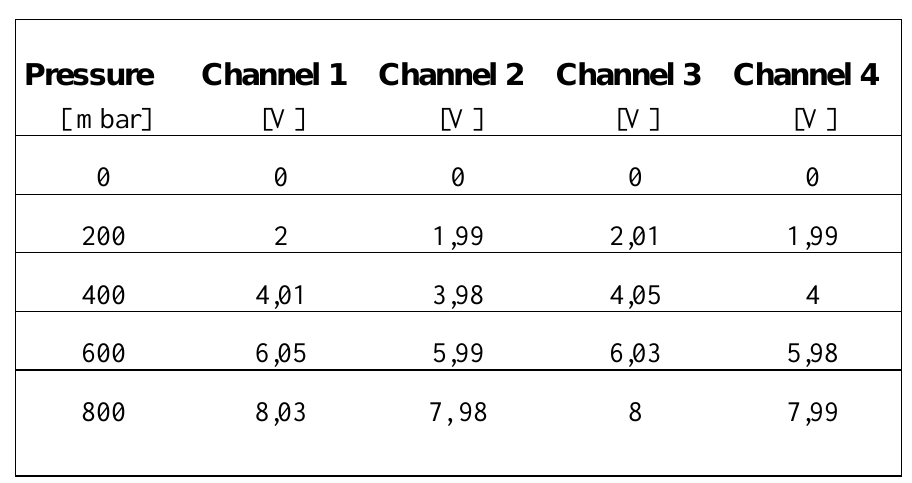
Table 1. Calibration results of deformational measuring